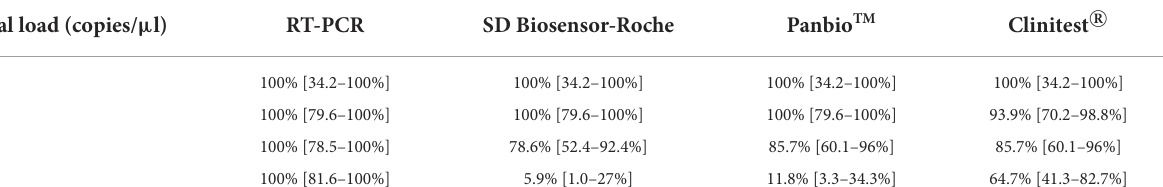
TABLE 3 Precision measure of diagnostic sensitivity of RATs by viral copies/ µ l with its 95% confidence interval (CI). Viral load (copies/ µ l) RT-PCR SD Biosensor-Roche Panbio TM Clinitest R (cid:13)